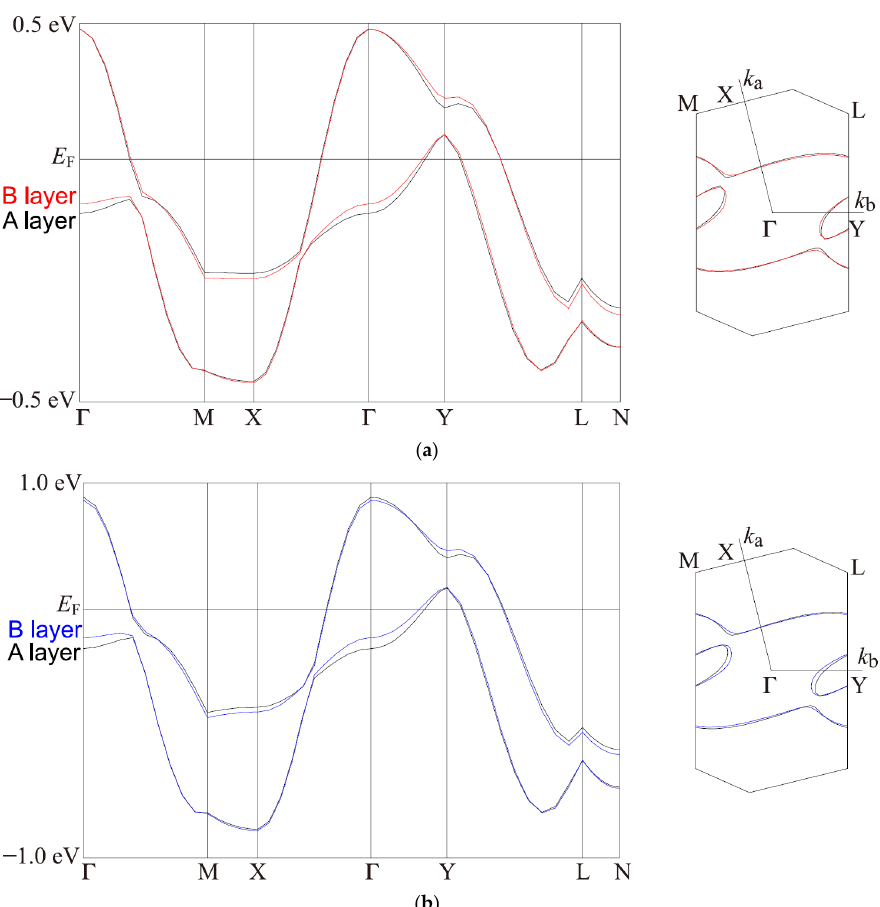
Figure 7. Band dispersions (left) and Fermi surfaces (right) of 1 ( a ) and 2 ( b ) at 150 K.